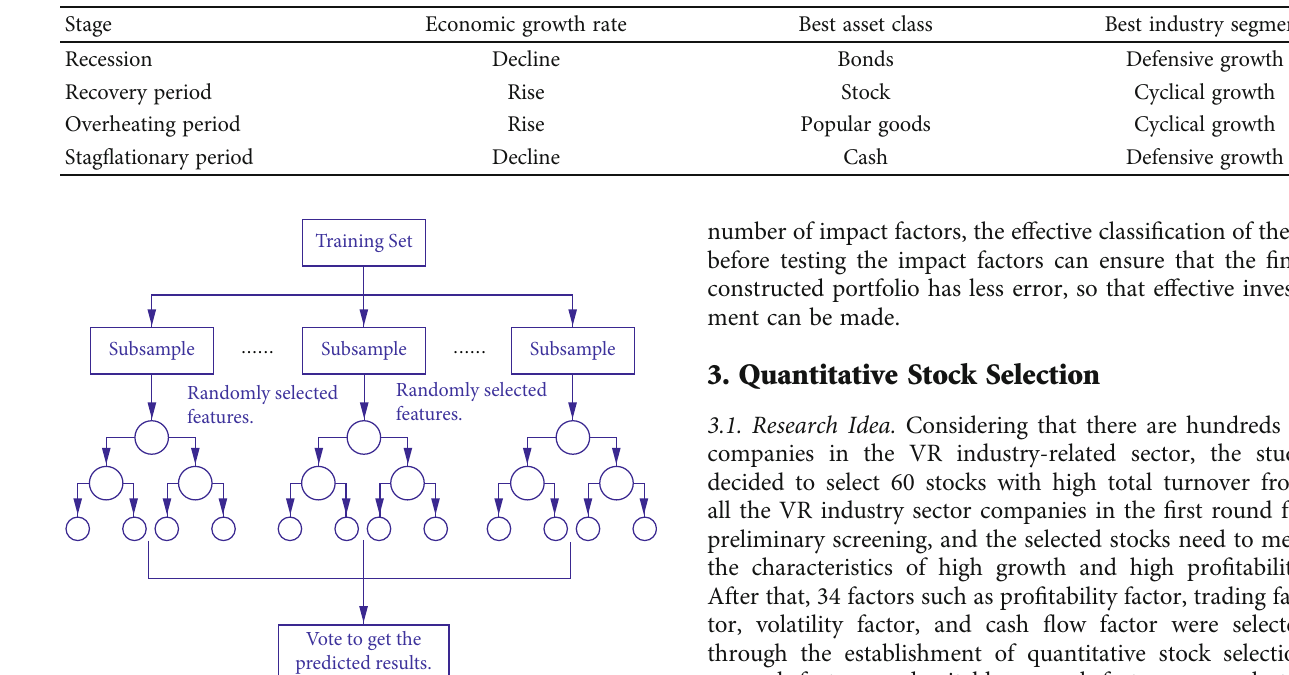
Table 1: The performance of di ff erent industries within the four phases.